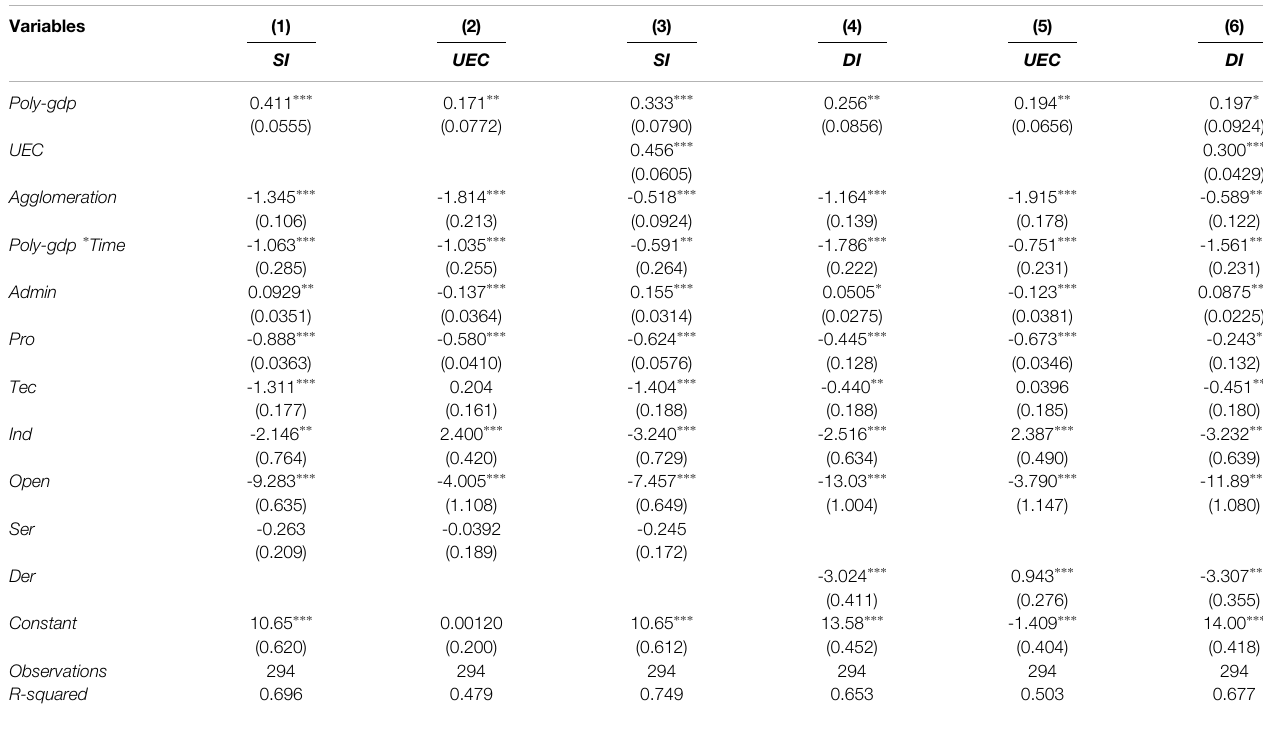
TABLE 8 | The mediating emission reduction effect of UEC